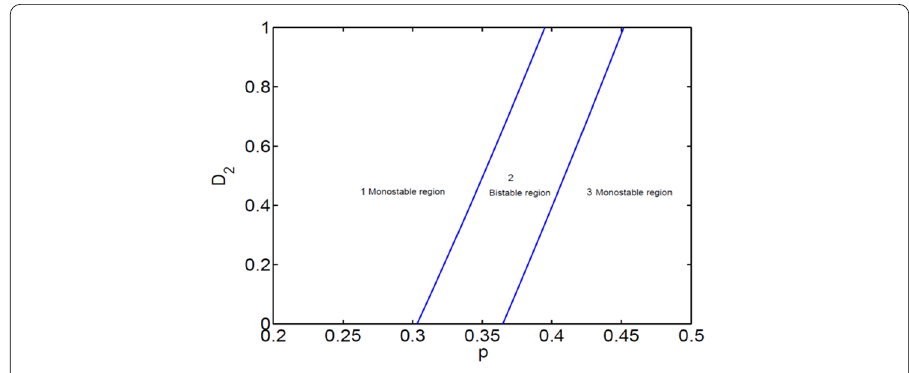
Figure 11 Transition set curves under multiplicative noise excitation (taking p and D 2 as unfolding